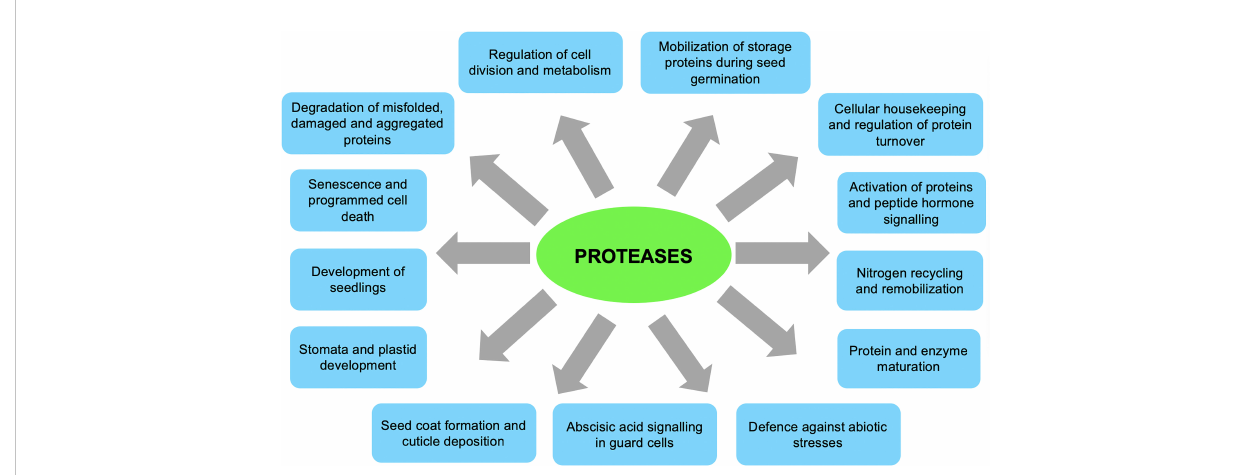
FIGURE 1 General functions of plant proteases in plant growth and development. (Brzin and Kidric ̌ , 1996; Vierstra, 1996; Schaller, 2004; van der Hoorn, 2008; Hopkins and Huner, 2009; Kato and Sakamoto, 2010; Kidric et al., 2014; van Wijk, 2015; Diaz-Mendoza et al., 2016; Sharma and Gayen,